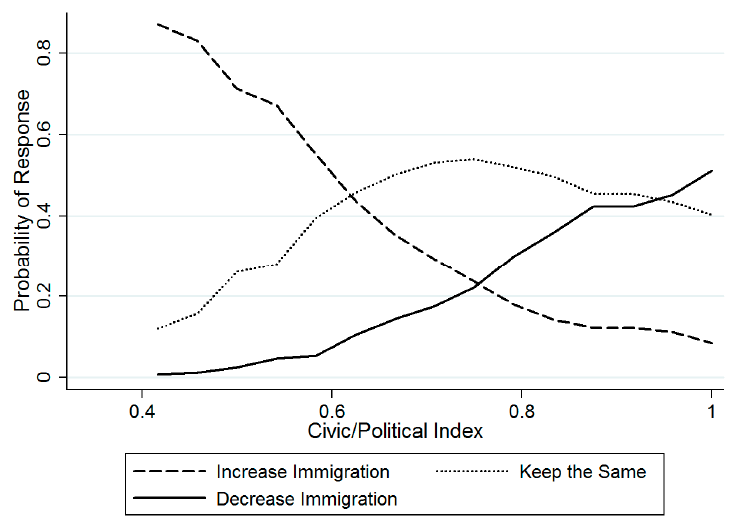
Figure 5. Predicted probability of response based on civic/political index score.